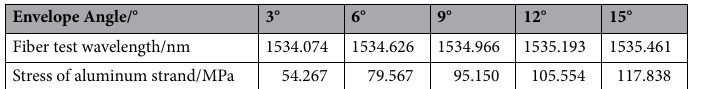
Table 10. Stress value test of aluminum strand under tension load of 10kN.